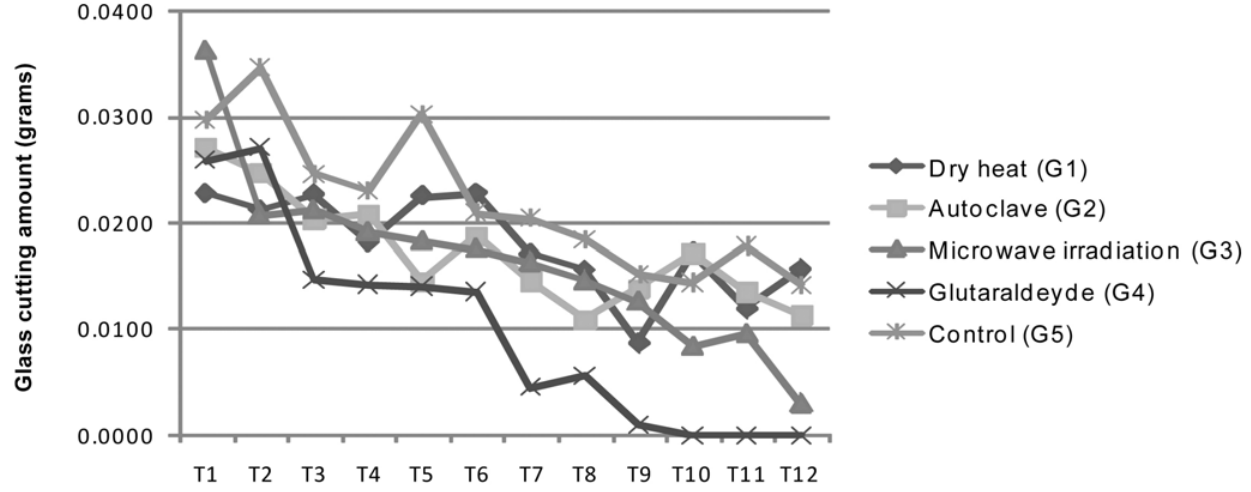
FIGURE 3- Changes in glass cutting amount after each 2.5-min cut period for each